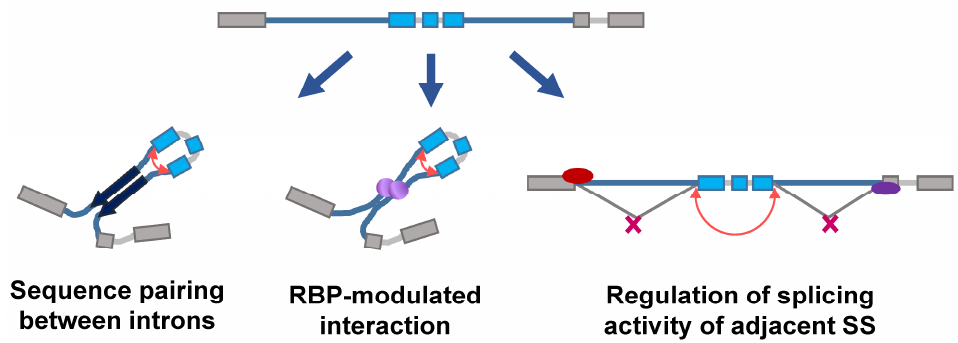
Figure 1. Different models controlling backsplicing. The given pre-spliced RNA ( top ) consists of introns (thin lines; blue ones for flanking long introns), circularizable exons (blue boxes) and the exons for linear splicing (grey boxes), and may undergo the following processes for backsplicing. The left panel shows the sequence-pairing dependent mechanism. A pair of arrows indicates the complementary sequences in the flanking long introns for circularizable exons. The red curved arrow indicates where the backsplicing takes place. Similarly, the interaction between flanking introns can be mediated by RBPs (middle panel, purple spheres). Alternatively, the splicing modulators (right panel, red or purple ovals) occupy the splicing signals (SS) and decrease the availability of splice donors in the upstream intron and/or the availability of splice acceptors in the downstream intron, inhibiting linear splicing and thereby favoring backsplicing.